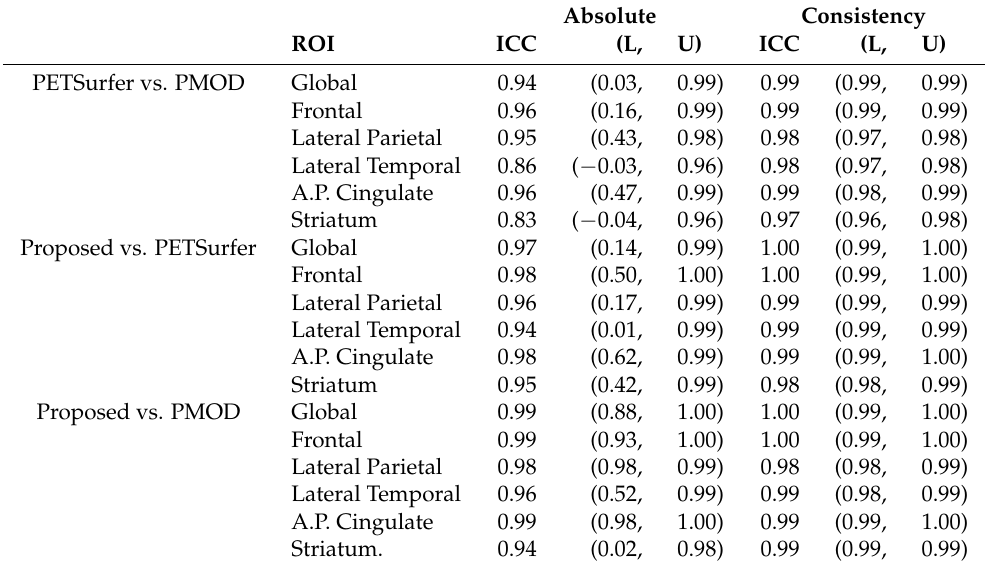
Table 4. Intra-class correlation coefficient (ICC) for three methods, PETSurfer, PMOD, and our proposed method. The paired ICC values are